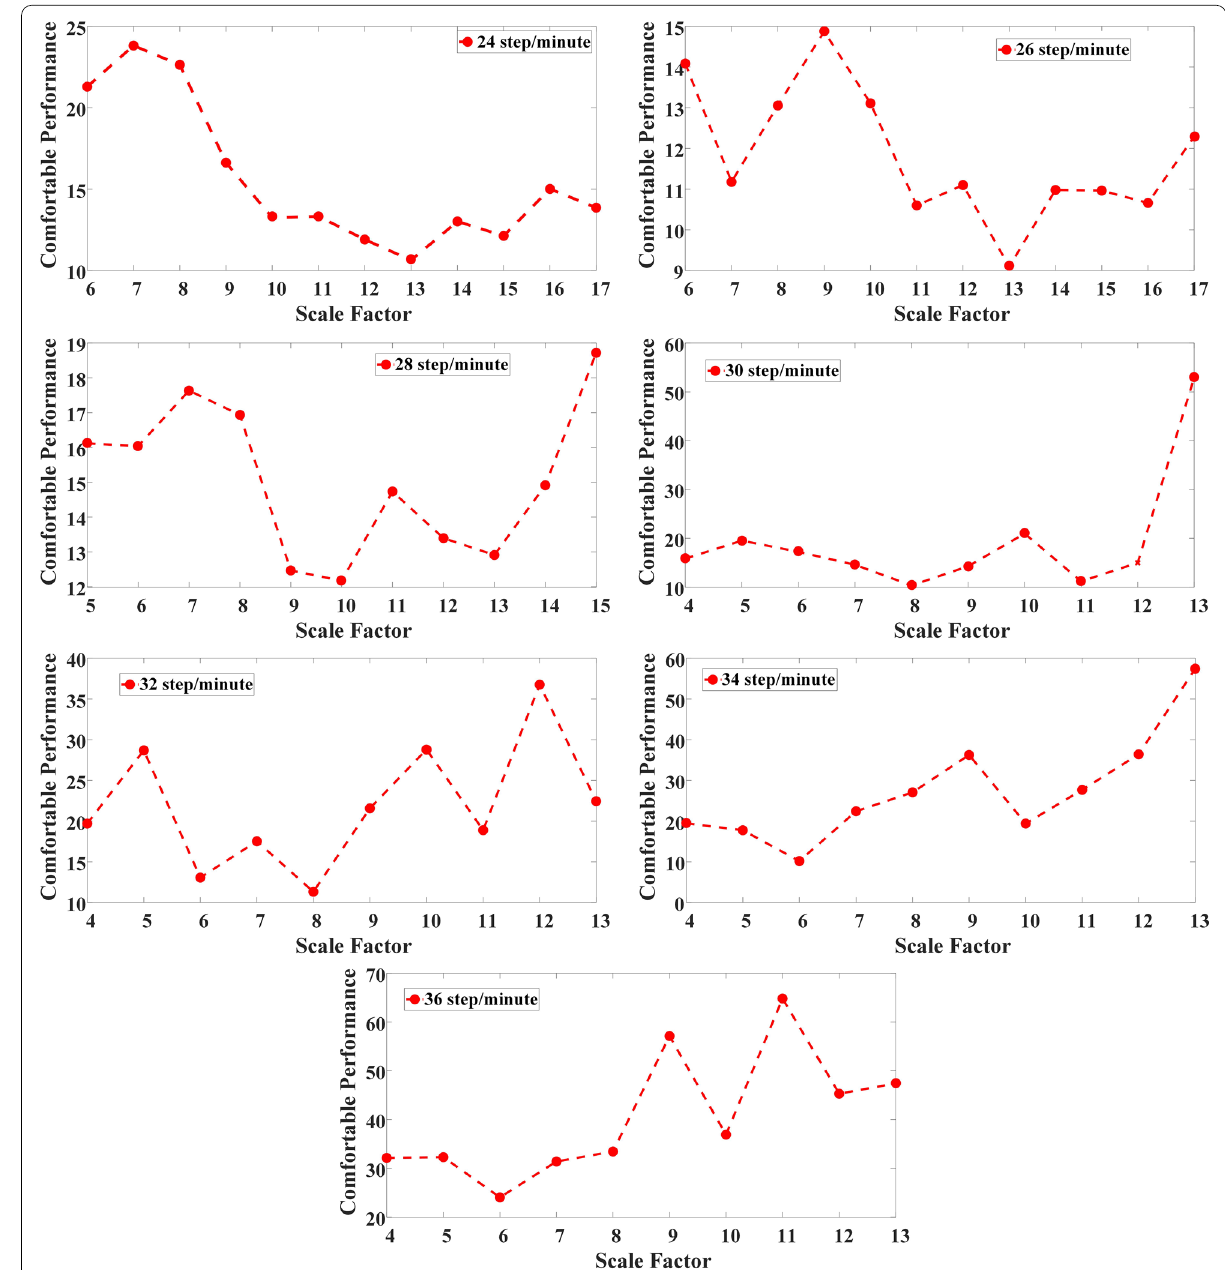
Figure 8 Wearable comfortable performance by using the admittance